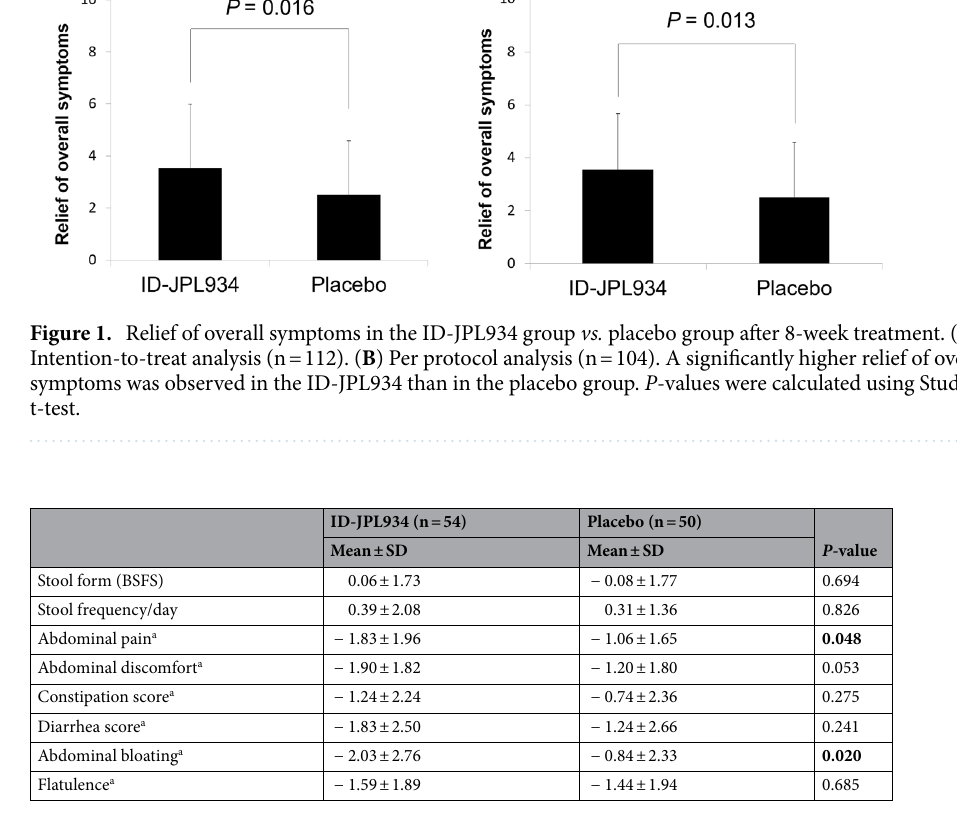
Table 2. Comparison of changes in stool form, frequency of bowel movements per day, and abnormal bowel movement symptoms from baseline to week 8 between the 2 groups. Per protocol analysis. P -values were calculated using Student’s t-test. Bold style denotes statistical significance. a Visual analog scale (0–10). BSFS, Bristol Stool Form Scale; SD, standard